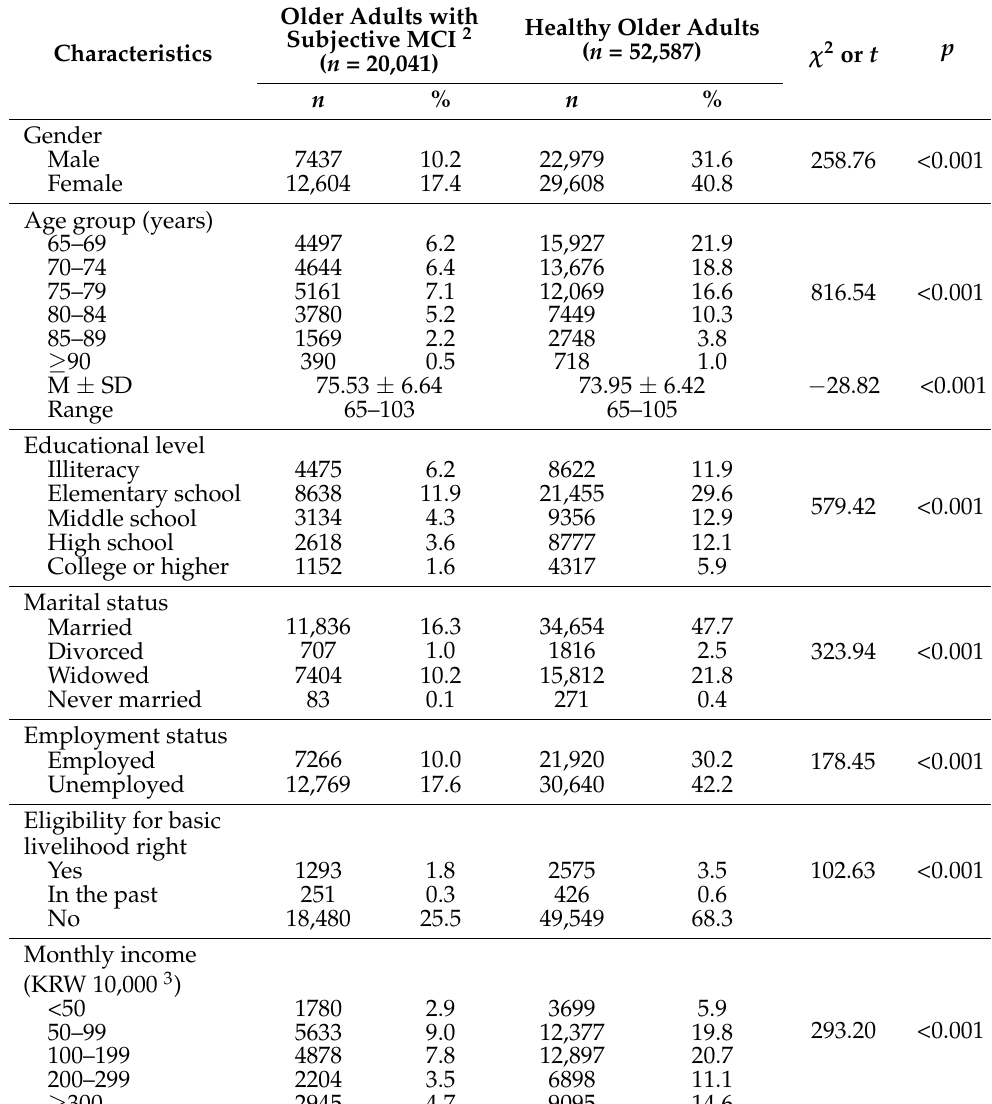
Table 1. Comparison of characteristics of older adults with subjective MCI and healthy older adults ( n = 72,628) 1